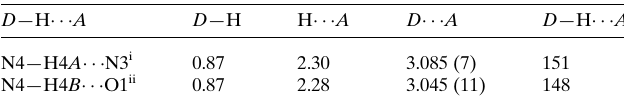
Table 1 Hydrogen-bond geometry (A˚ , (cid:4) ).